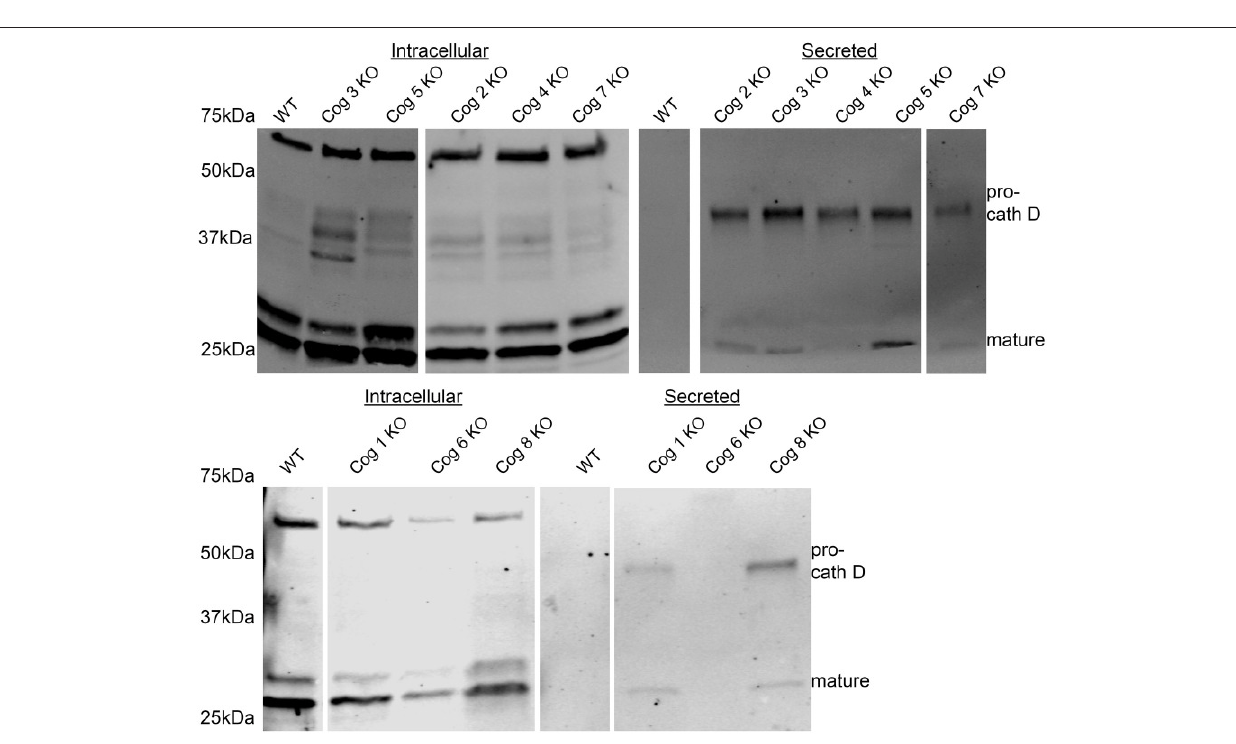
of incubation with cells. We found that all cells lacking COG subunits (with the exception of Cog6) but not the original HEK293T cells secrete immature Cathepsin D (a lysosomal protease), indicating defects in post-Golgi sorting and/or endosome/lysosome impairments ( Figure 8 ). Interestingly some, but not all KOs also secrete a small amount of mature Cathepsin